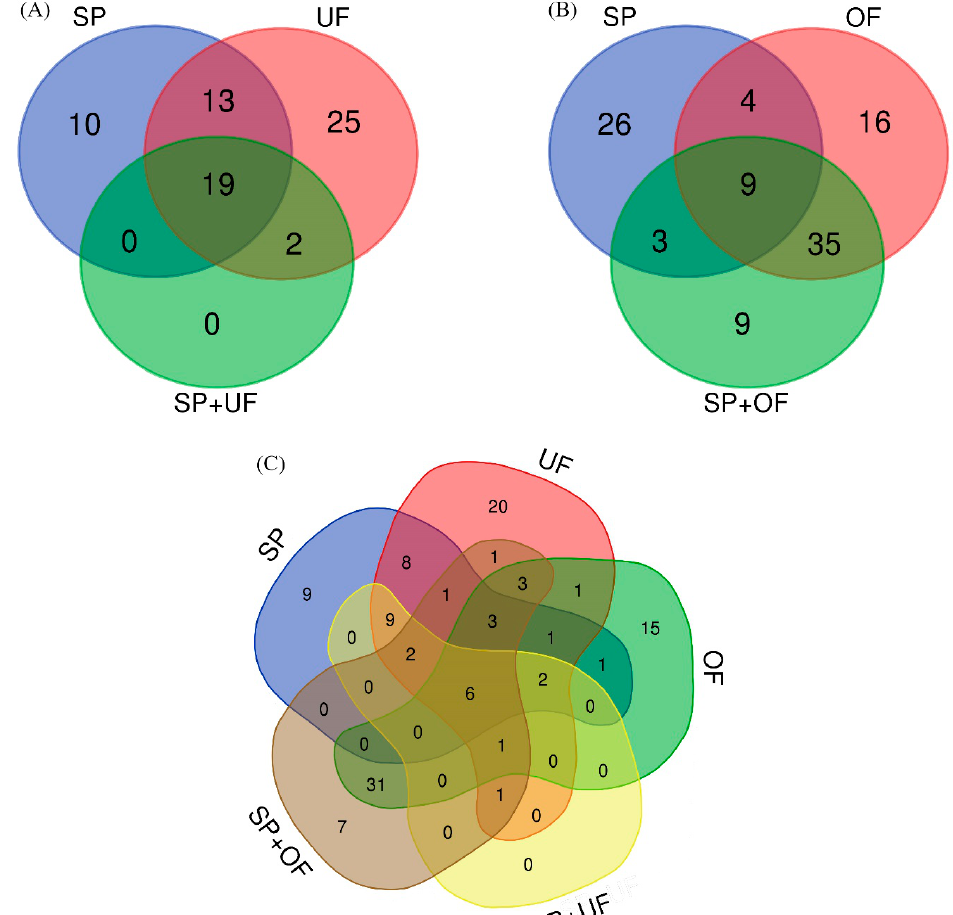
Figure 1. Venn diagram illustrating the number of different proteins in each incubation: the overlap of seminal plasma (SP), uterine fluid (UF), and seminal plasma plus uterine fluid (SP + UF) sperm-interacting proteins ( A ); the overlap of SP, oviductal fluid (OF), and seminal plasma plus oviductal fluid (SP + OF) sperm-interacting proteins ( B ); and the overlap of the different incubation fluids ( C ).